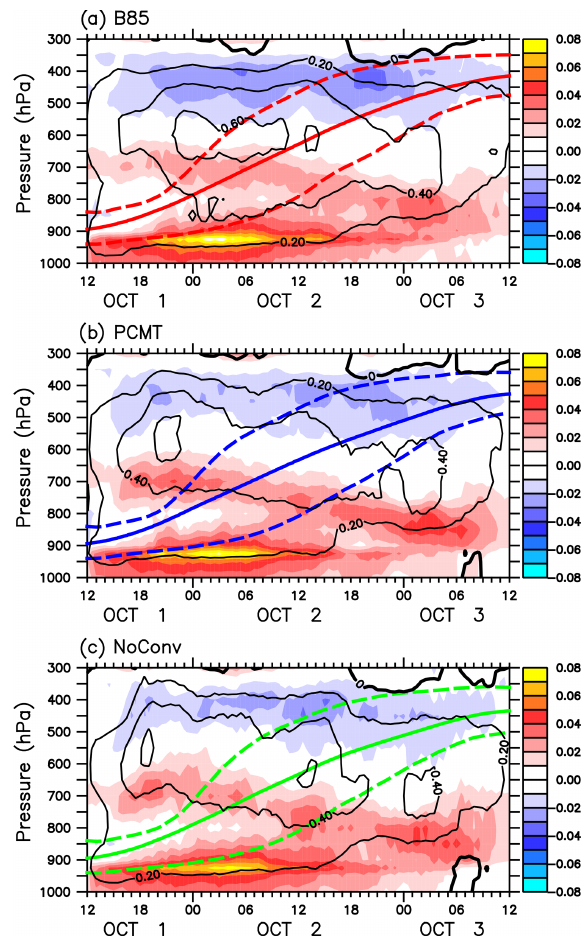
Figure 3. Time evolution of the mean vertical profiles along all WCB trajectories of the heating rate (interval: 0.20Kh − 1 ) and the PV tendency part due to the vertical derivative of the heating (inter- val: 0.01PVUh − 1 ) for (a) B85, (b) PCMT and (c) NoConv simula- tions. The mean pressure of the WCB trajectories is shown in solid lines and the 25th and 75th percentiles in dashed lines.